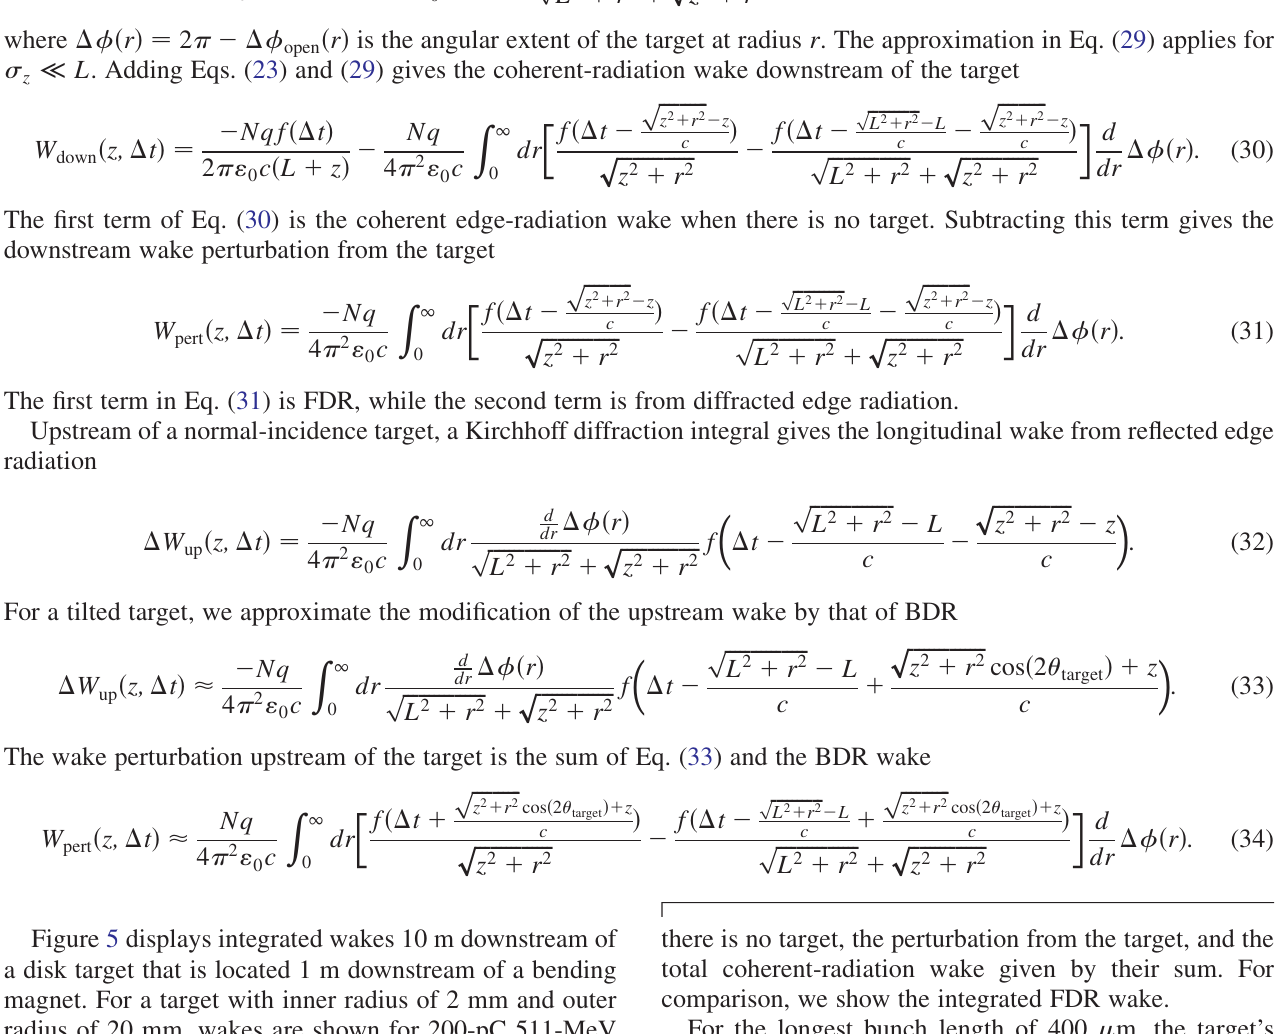
p ffiffiffiffiffiffiffiffiffiffiffiffiffiffiffi z 2 þ r 2